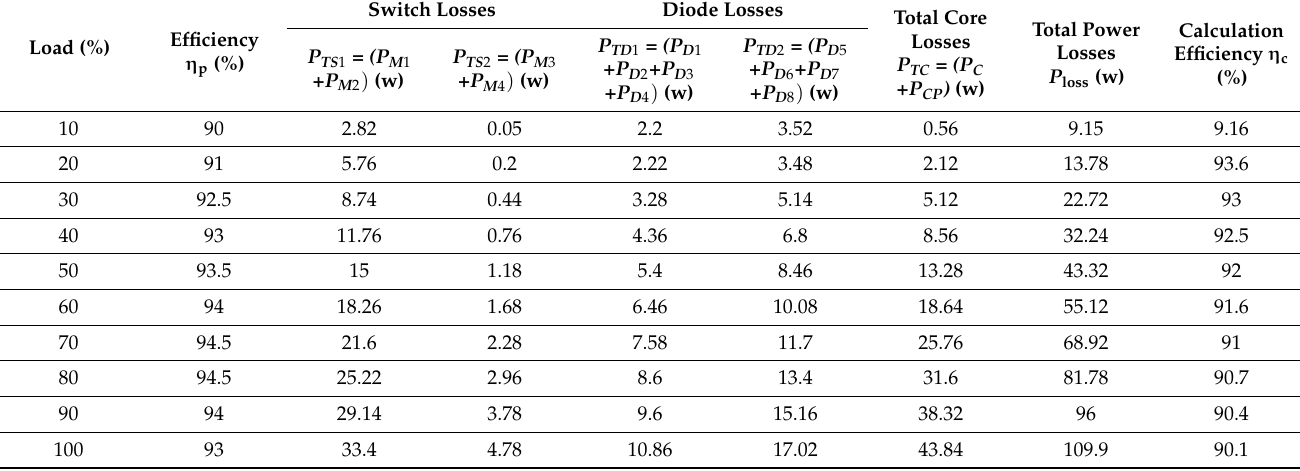
Table 6. Power loss analysis for the proposed boost converter under input voltage of AC 110